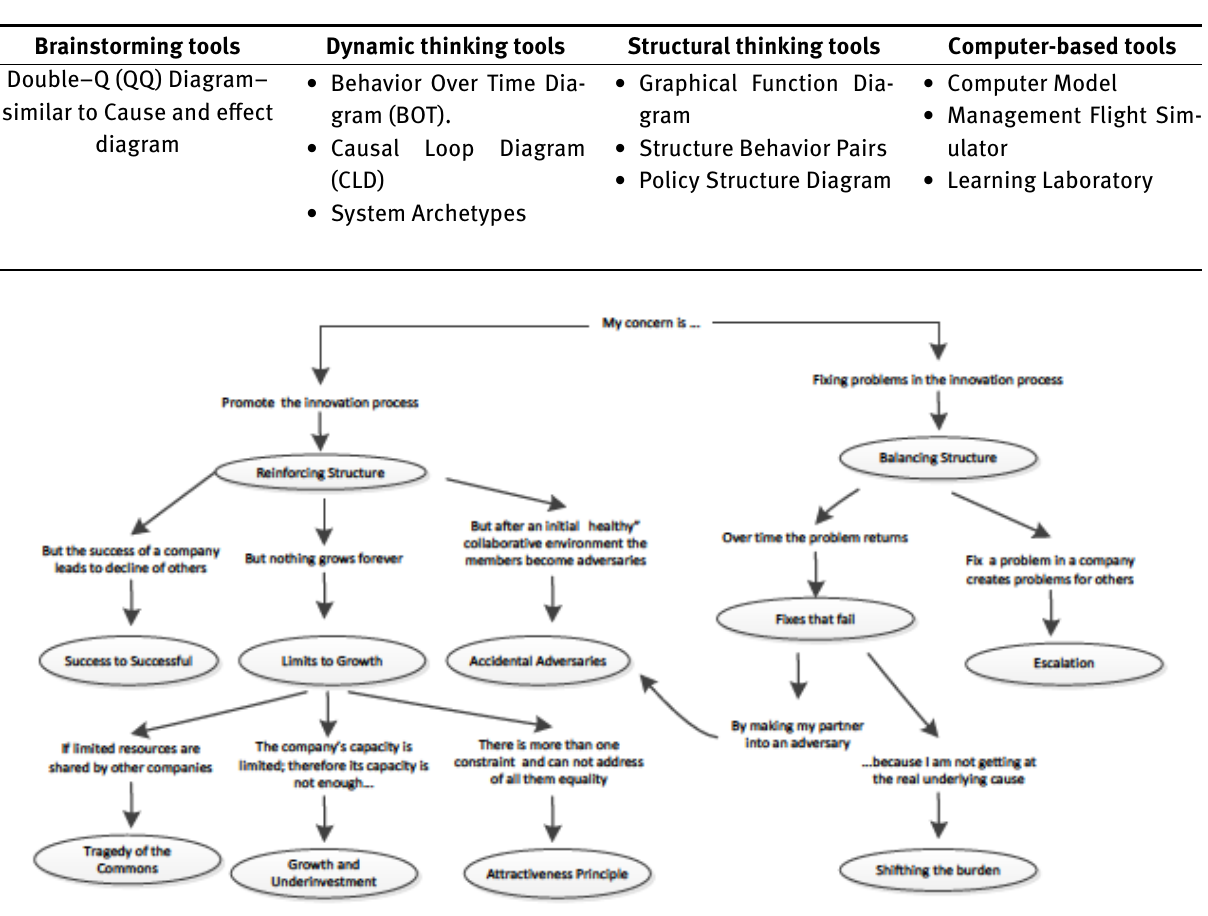
Table 1: System Thinking Tools.